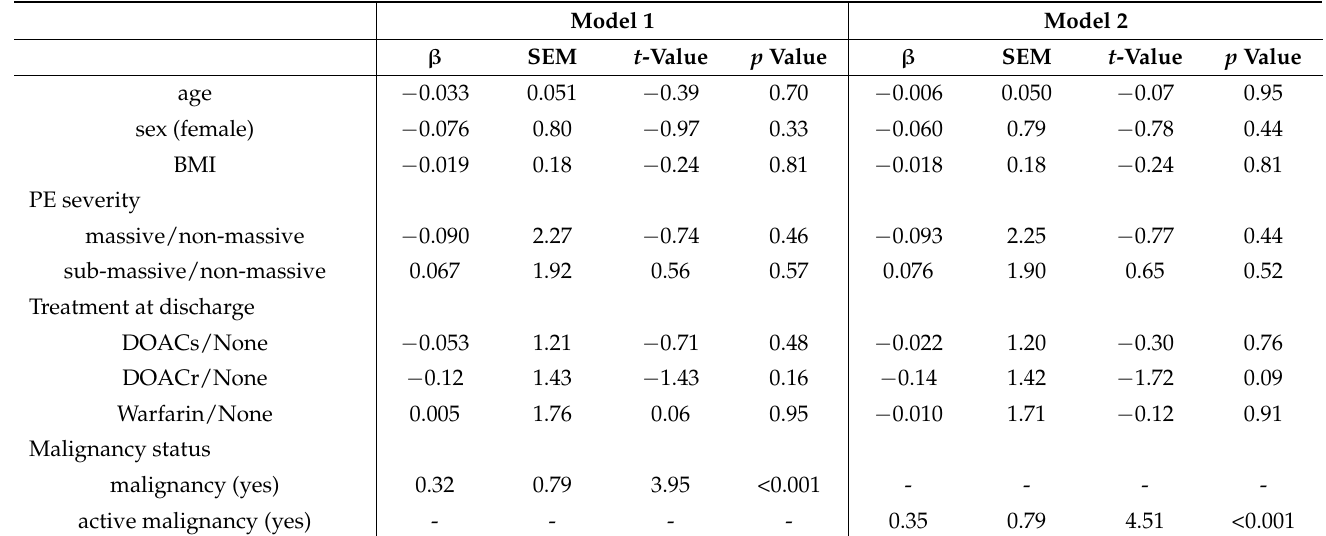
Table 3. Multiple regression analysis for D-dimer level at